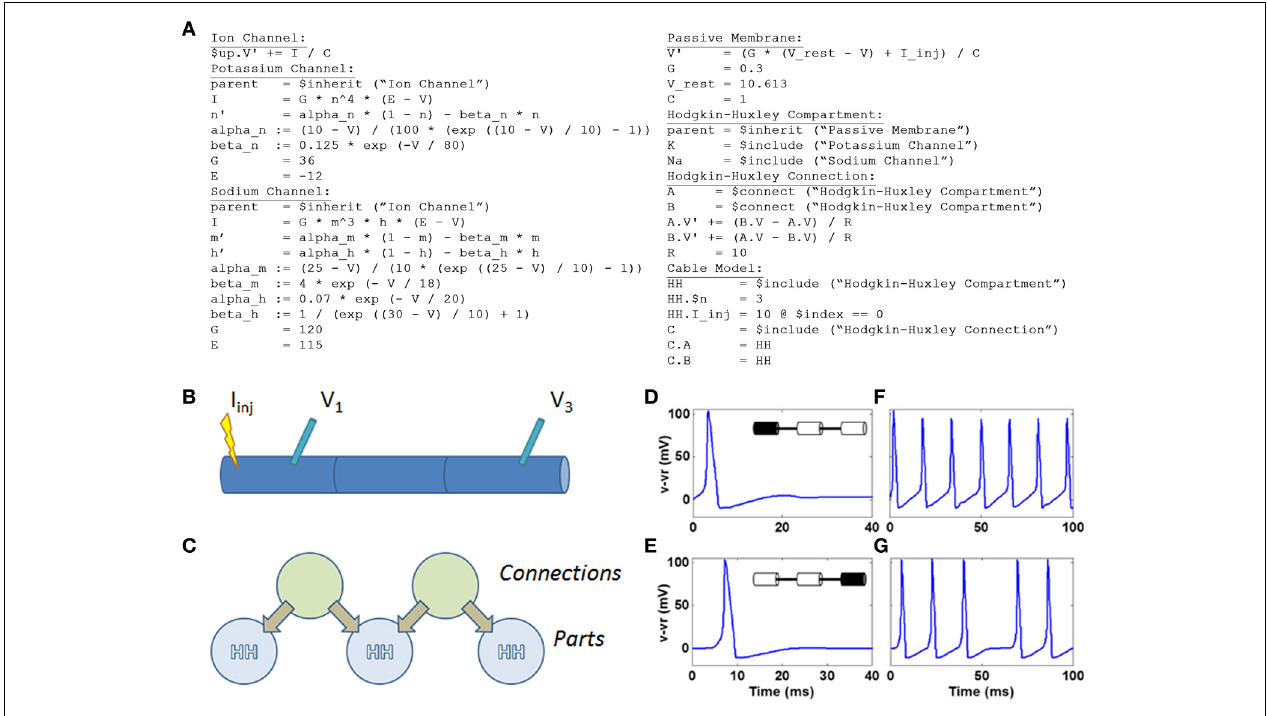
FIGURE 7 | HH model defined within N2A and simulated on Xyce. (A) N2A language depiction of HH dynamics (B) Cartoon illustration of 3 compartment HH cable. Current is injected into left compartment and measured in left and right compartments (C) N2A representation of HH